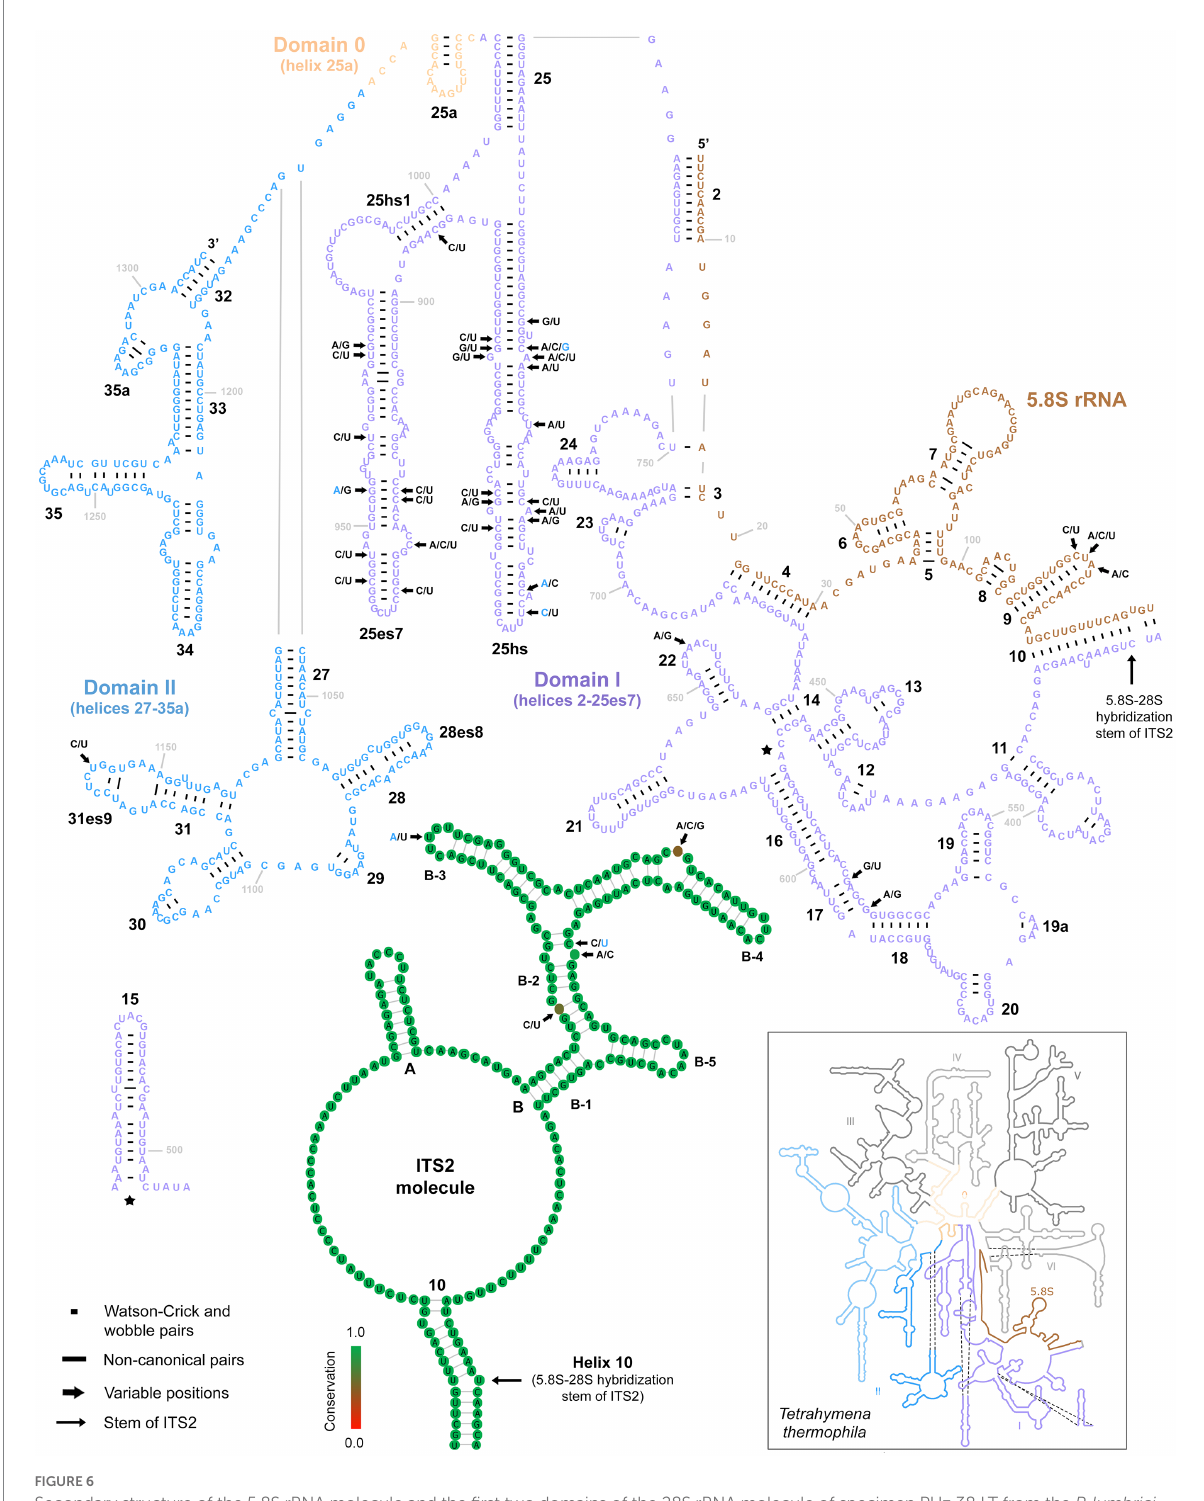
FIGURE 6 Secondary structure of the 5.8S rRNA molecule and the first two domains of the 28S rRNA molecule of specimen PUz 38 LT from the P. lumbrici complex as well as the consensus secondary structure of the ITS2 molecules of 115 Plagiotoma specimens. Variable nucleotide positions are marked by thick arrows and diagnostic molecular autapomorphies of P. aporrectodeae sp. n. are denoted by blue color. Only three variable positions were present in the 5.8S rRNA molecule and all were accumulated in the terminal loop of helix 9. Internal transcribed spacer 2 was similarly conservative, harboring only five polymorphic positions. Finally, there were as many as 31 mutations in the first two barcoding domains of the 28S rRNA molecule. All but one were situated in the first domain. The 5.8S-28S secondary structure map of Tetrahymena thermophila (inset) is from